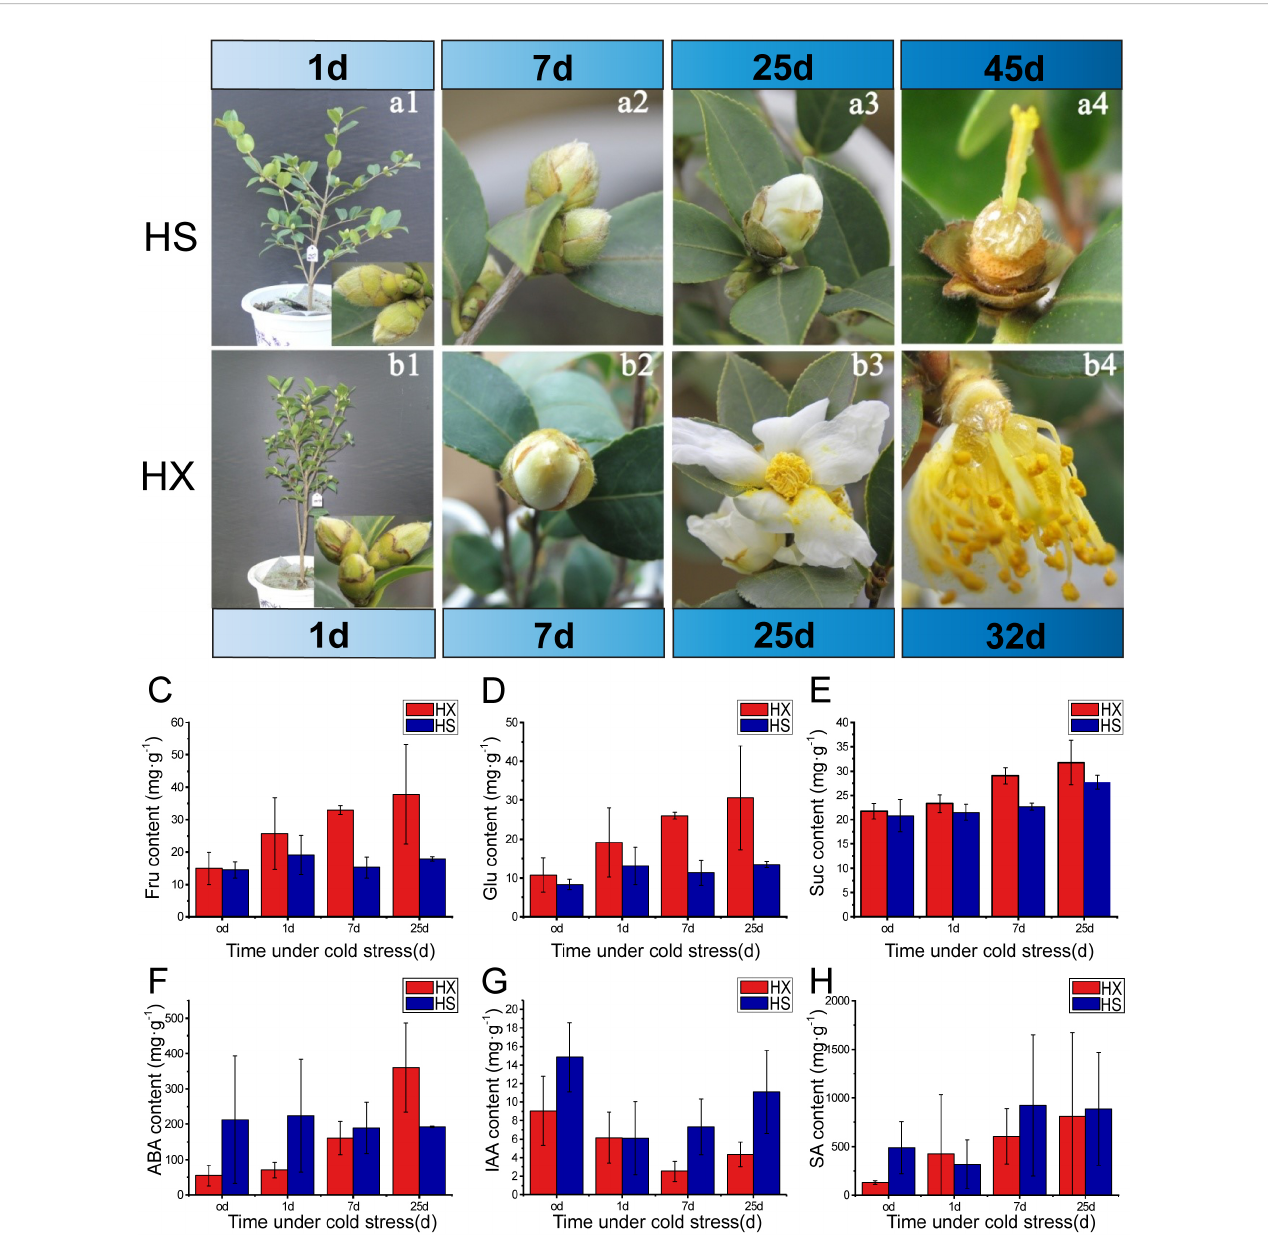
FIGURE 2 Effects of cold stress on phenotype, sugar content, and phytohormone content: bud morphology and fl owering of HS (a1-a4) , and HX (b1-b4) during the treatment period; the contents of (C) D-fructose, (D) glucose, (E) sucrose, (F) ABA, (G) IAA, and (H) SA in fl ower buds of HS and HX under different cold